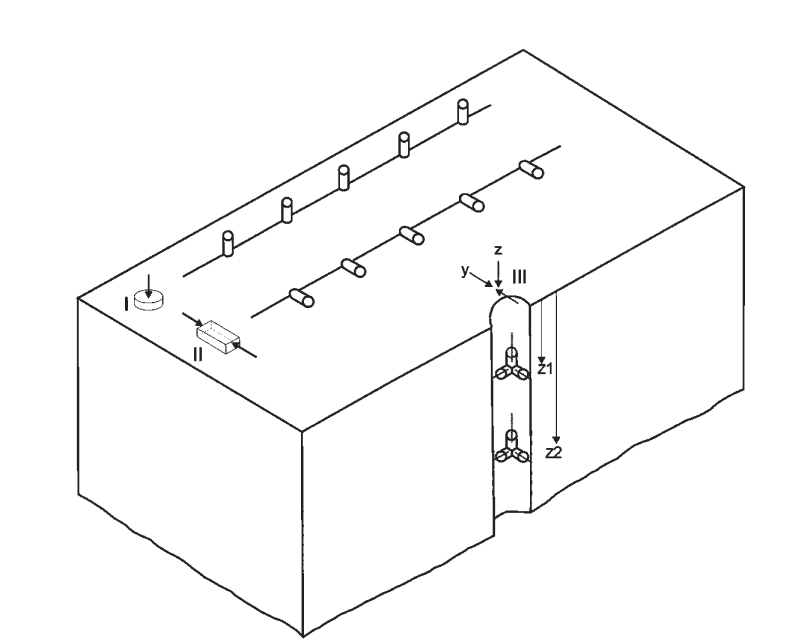
Fig. 4. Schematic of seismic Profiles: I-refraction P-wave, II-refraction S-wave and III-